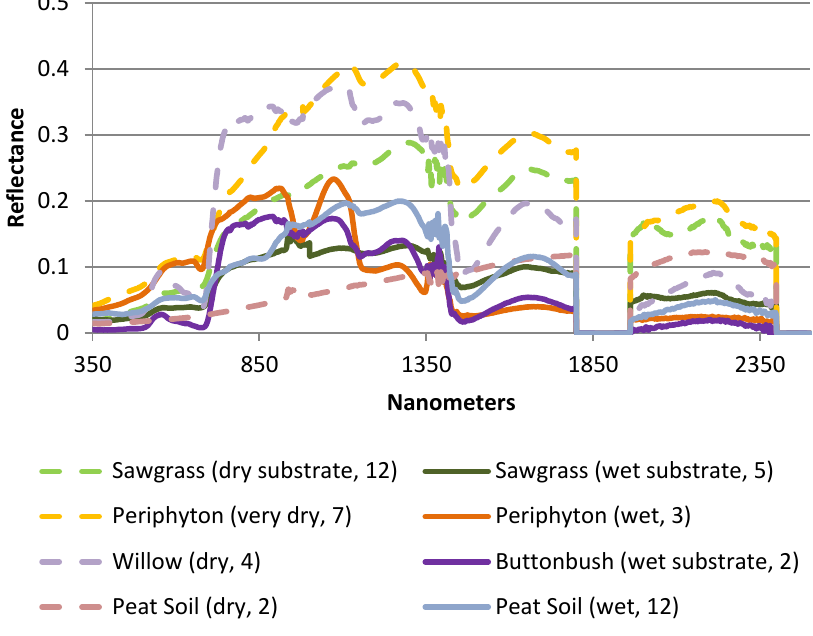
Figure 2. Spectra for dominant Everglades marshland covers as well as common woody plants that border Everglades marshlands. The inundation status of each vegetation type as noted at the time of collection and number of samples are provided in